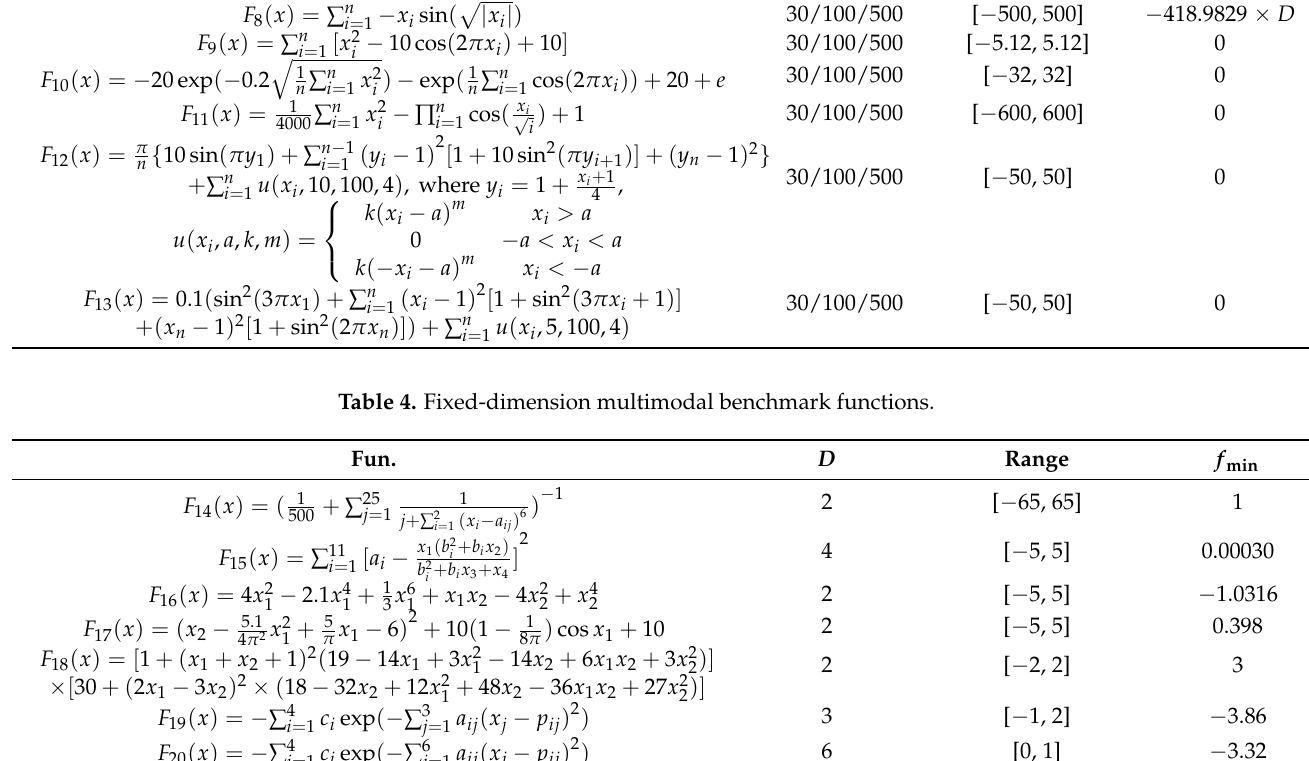
Table 3. Multimodal benchmark functions. Fun.